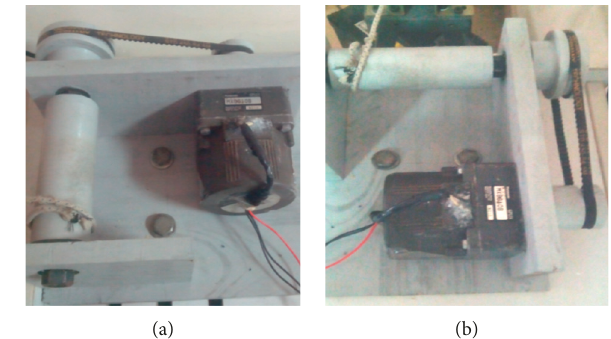
Figure 12: Transmission system.